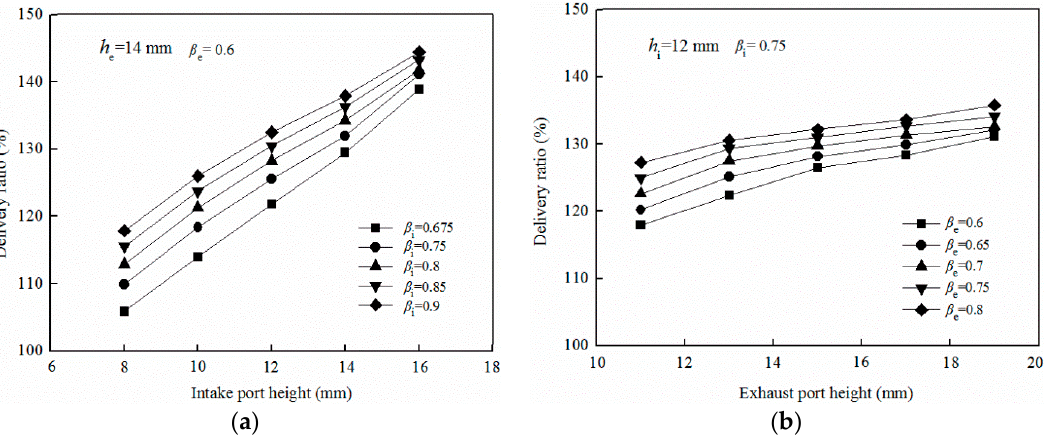
Figure 9. Effect of the port height and circumference ratio on delivery ratio ( a ) Intake port; ( b ) Exhaust port.